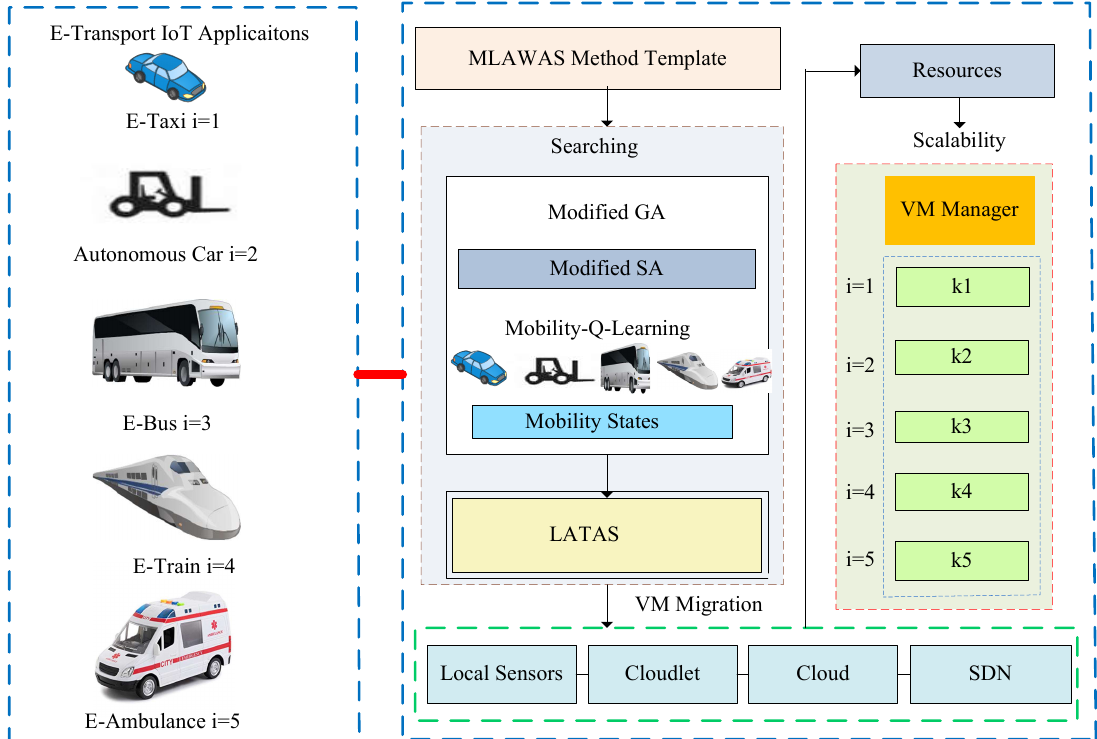
Figure 1. IoT E-Transport